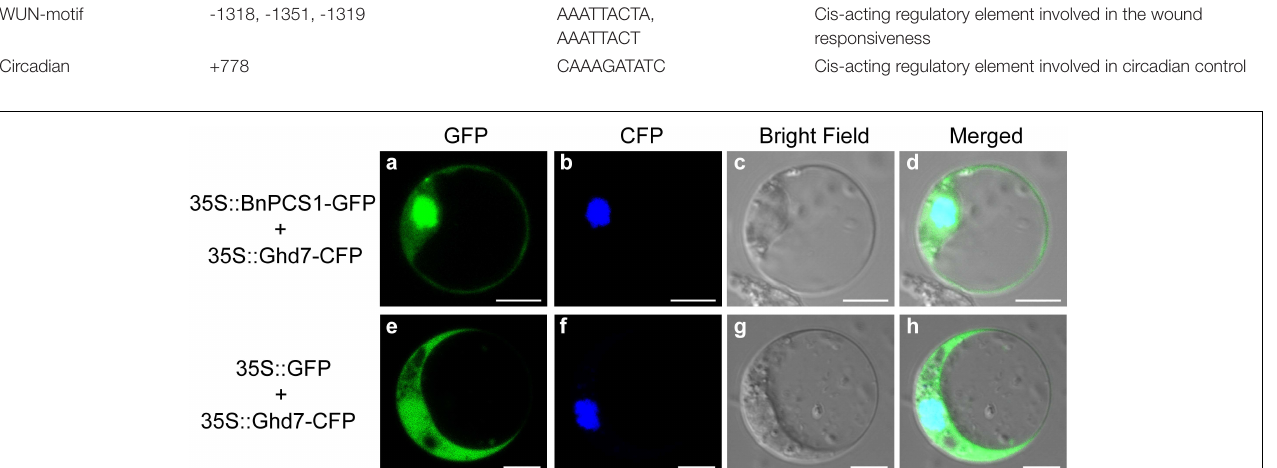
FIGURE 2 | Subcellular localization of BnPCS1. Recombinant plasmid 35S::BnPCS1-GFP and the empty vector 35S::GFP were transfected separately into Arabidopsis protoplasts with nuclear marker 35S::OsGhd7-CFP. The CFP and GFP fluorescence signals were observed using a laser confocal microscope. (a) 35S::BnPCS1-GFP; (b) 35S::OsGhd7-CFP; (c) bright field; (d) overlap images of (a–c) ; (e) 35S::GFP; (f) 35S::OsGhd7-CFP; (g) bright field; (h) overlap images of (e–g)